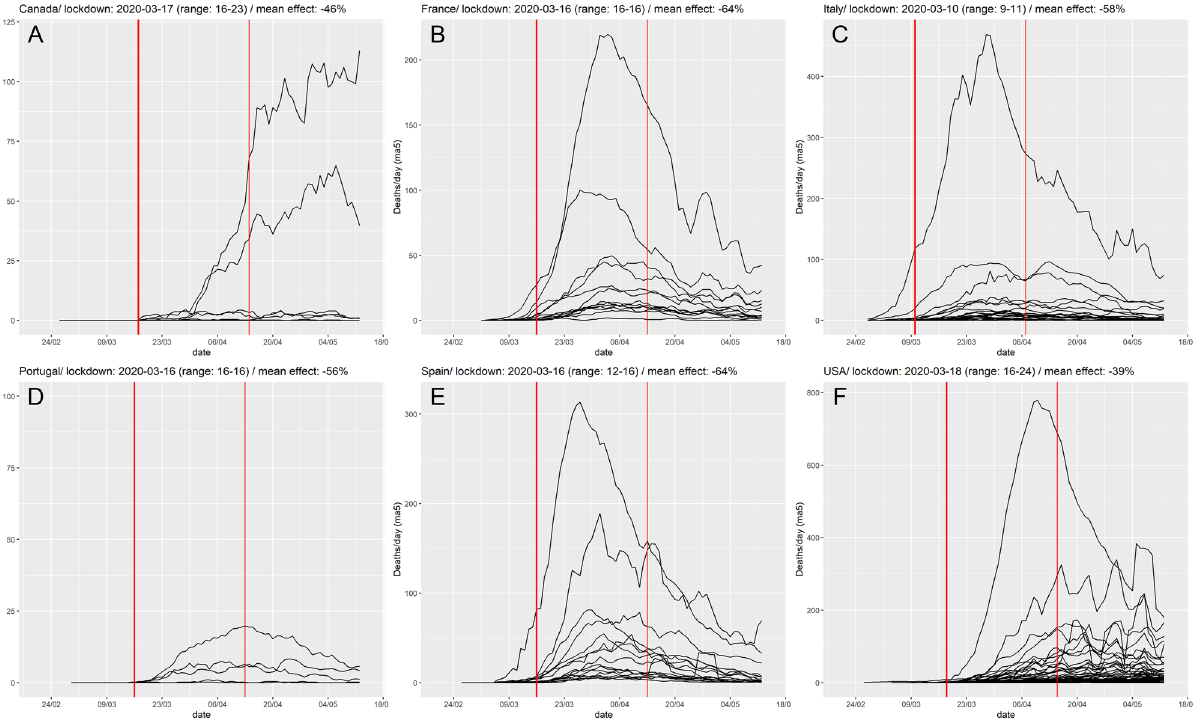
Figure 2. Deaths per day, by region and by country. The thick red line figures the median date of lockdown by each country, and the thin red line the median date + 28